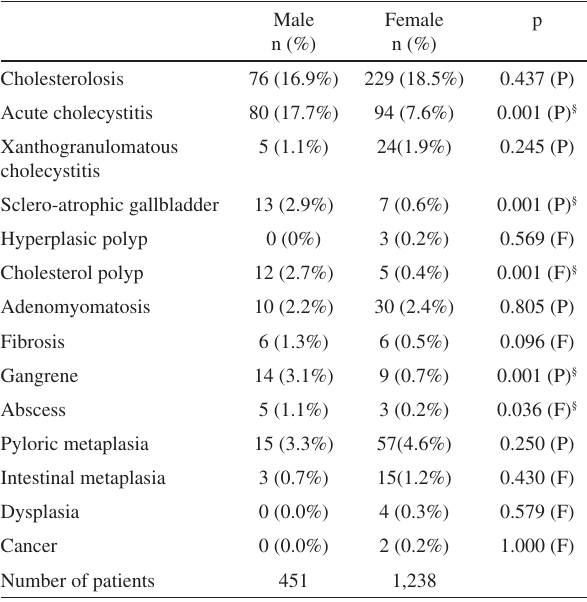
Table 2 - Analysis of the gallbladder histological alterations according to gender.